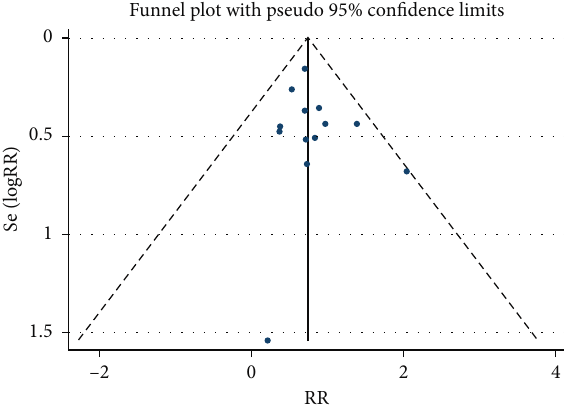
Figure 4: Comparison of PMI between the experimental group and the control group (funnel plot). RR � risk ratio; PMI � periproce- dural myocardial injury.